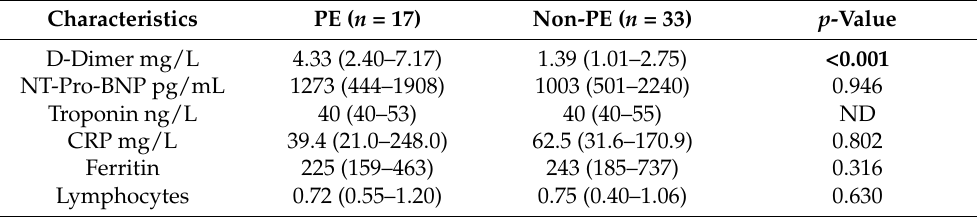
Table 2. Laboratory characteristics between the PE and non-PE groups.